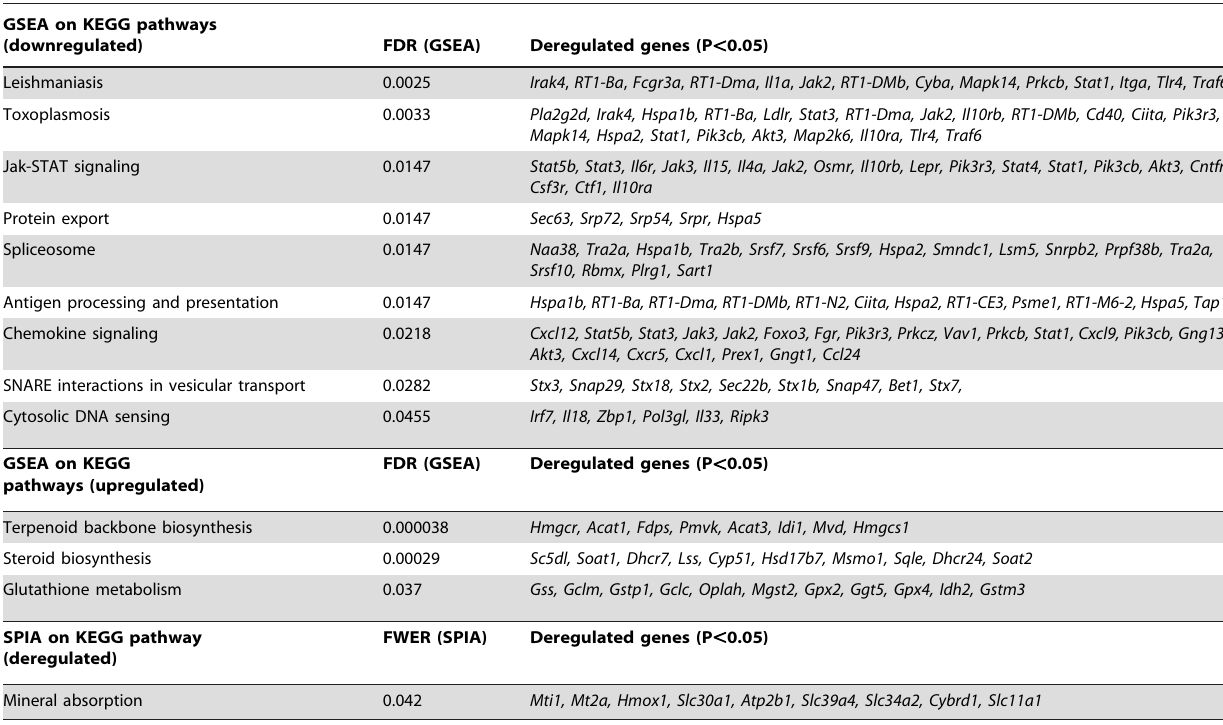
Table 3. KEGG pathways determined by GSEA and SPIA